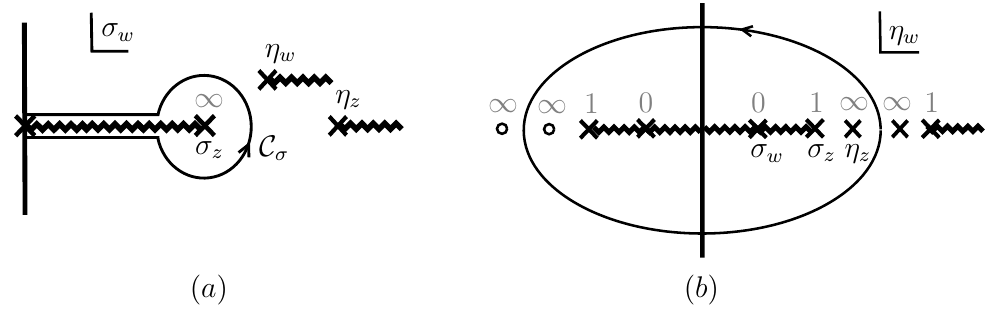
Figure 4 . The integration contour used in eq. (4.8) to prove the dispersion relation is a product of a keyhole and a circle. (a) (cid:27) w -plane: the keyhole C (cid:27) starts and ends at (cid:27) w = 0. (b) (cid:17) w -plane: the integral over the circle j (cid:17) w j = 1 vanishes and is equal to the sum of the pole and cuts in its interior. The pole gives minus the correlator G ( z; (cid:22) z ) and the cuts give the dispersion integral. Values of x are shown in light gray above the